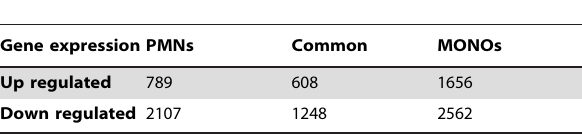
Table 1. Numbers of gene changing expression measured by genome-wide microarray analysis after 4 hr of endotoxin stimulation in polymorphonuclear leukocytes (PMNs) and monocytes (MONOs) of the newly born (n=5).